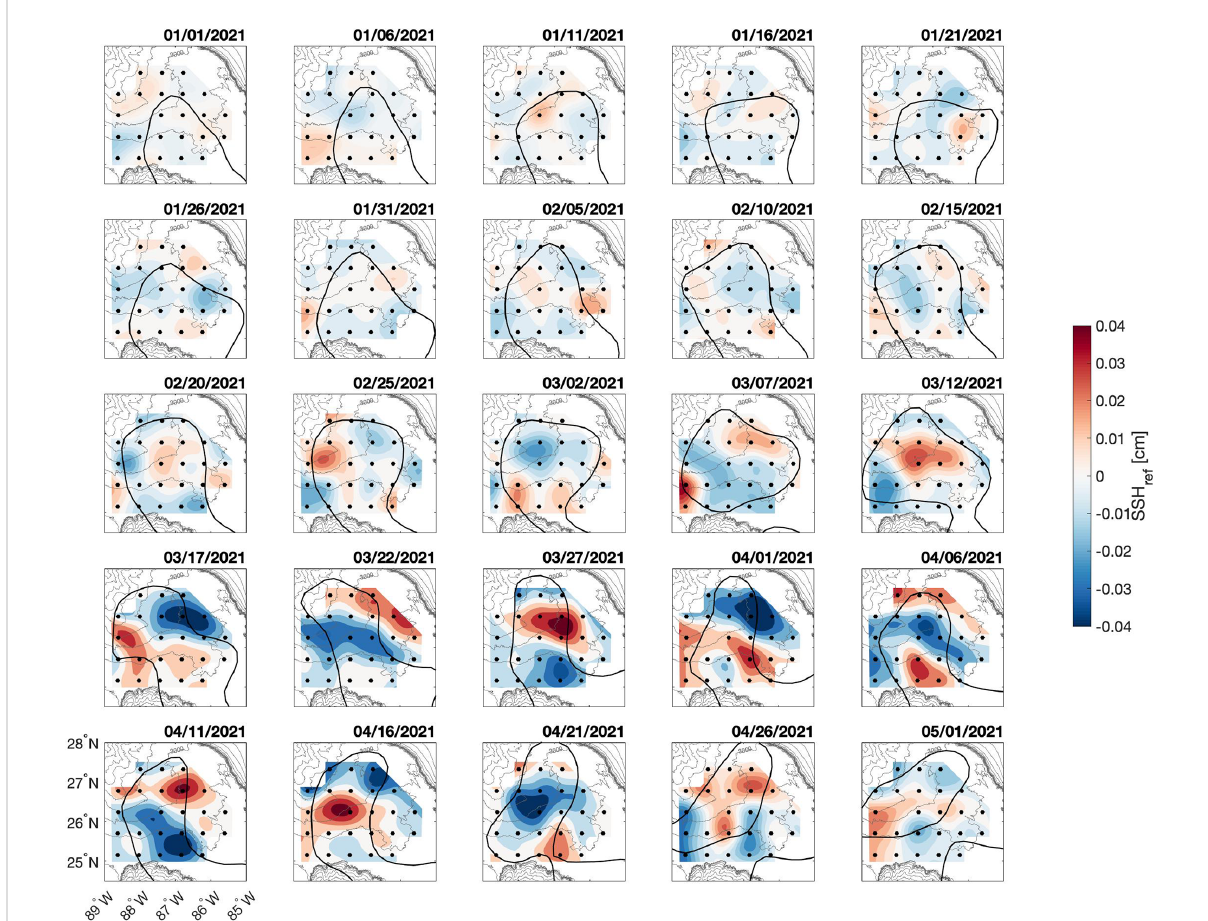
FIGURE 8 Mapped SSH ref at fi ve-day intervals during LCE Ursa shedding event, January-May 2021. SSH ref is band-passed with a 1/20 – 1/10 day – 1 fi lter. The bold SSH contour represents the location of the LC at each time step. CPIES locations are marked by black circles and bathymetry is contoured in light gray every 250